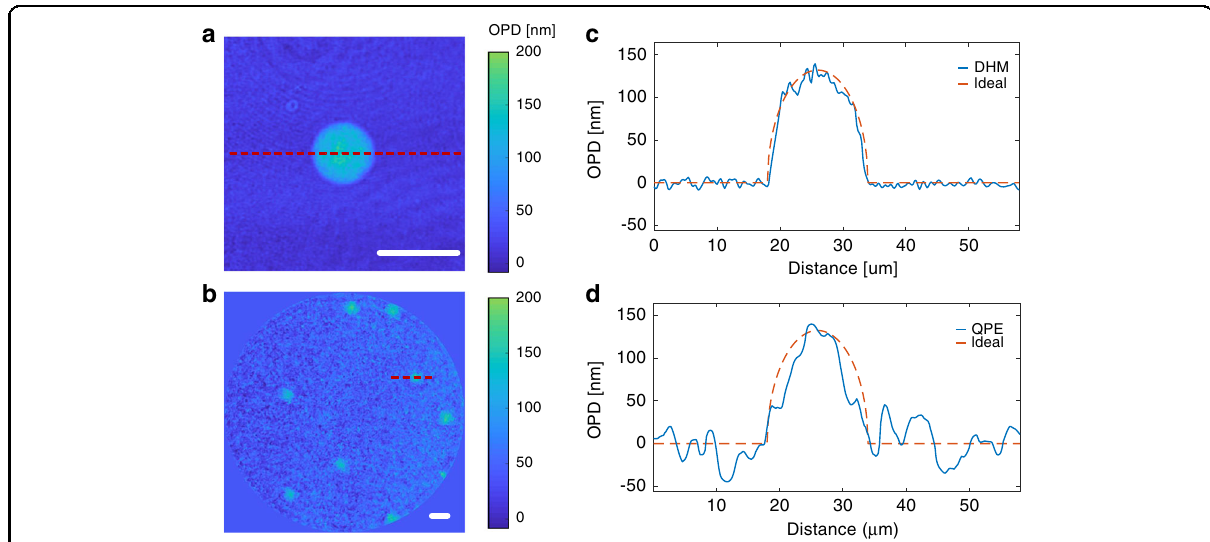
Fig. 5 Quantitative phase imaging of micro-gel beads via microendoscope. Quantitative optical path difference (OPD) map of PAAm micro-gel beads acquired with a digital holographic microscope (DHM), b quantitative phase microendoscope (QPE). Scale bars 20 μ m. c , d OPD distribution along the red marked lines in the maps on the left side. The dashed lines represent the ideal OPD distribution of the PAAm